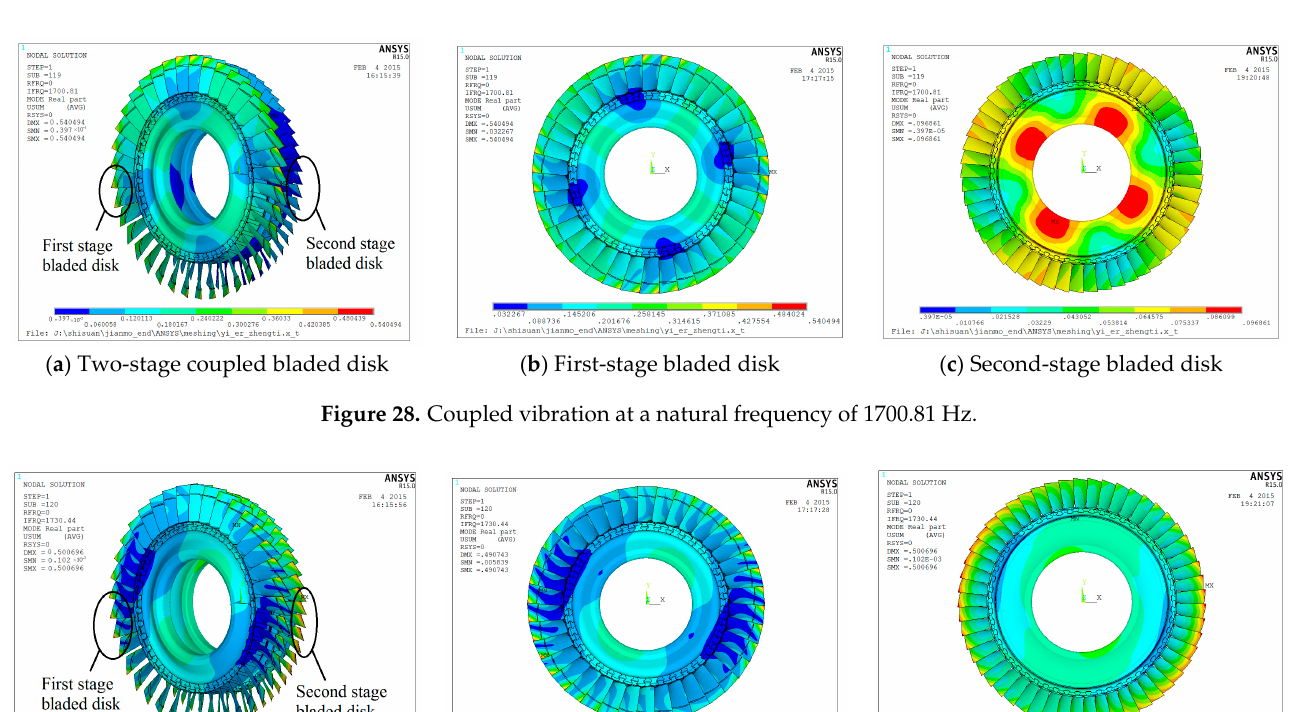
Figure 27. Coupled vibration at a natural frequency of 1548.55 Hz.